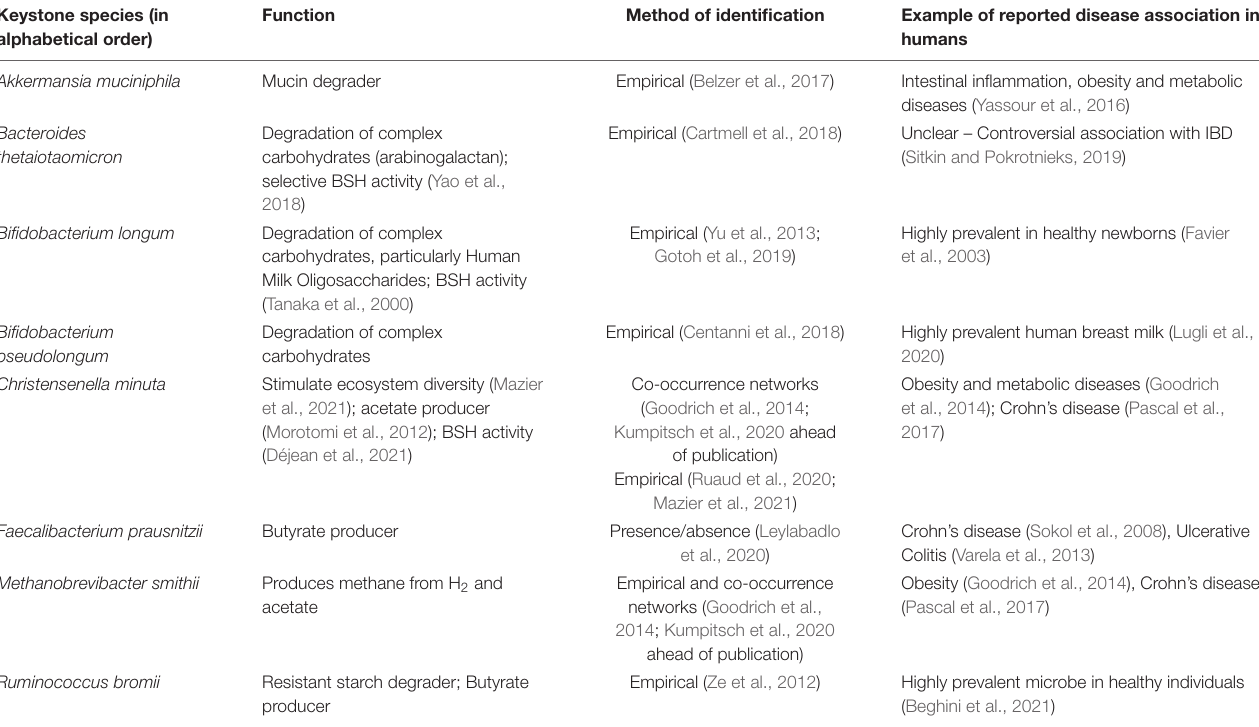
TABLE 1 | Non-exhaustive list of prominent keystone taxa of the human gut